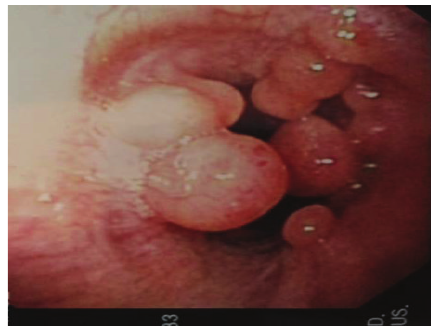
Figure 4: Octreotide scan showing abnormal activities in the right hilum and carinal area as well as liver suggestive of metastatic